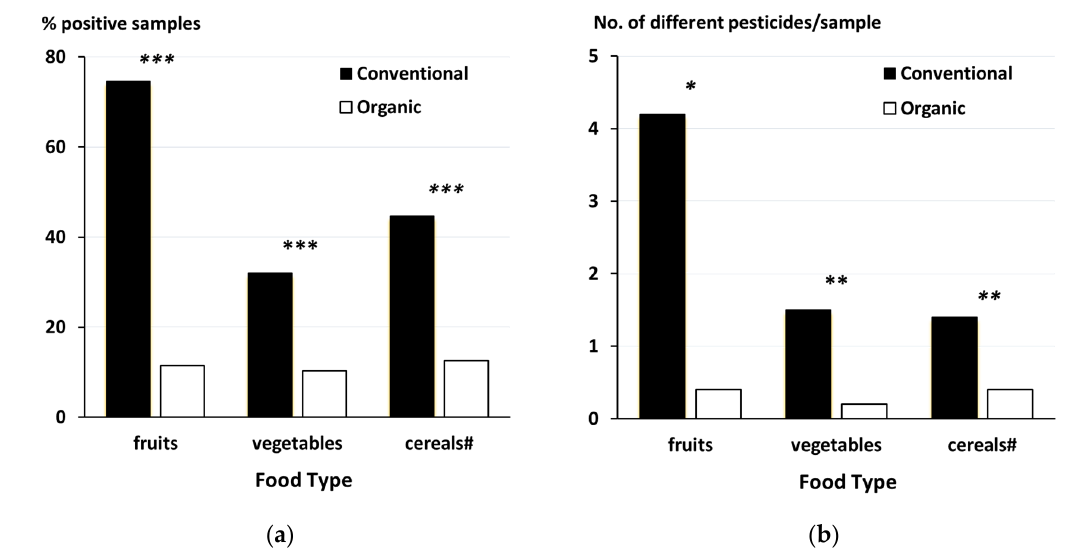
Figure 7. Effect of organic and conventional production methods on ( a ) the percent of samples testing positive for at least one pesticide residue. Data from [57], and ( b ) the number of different pesticide residues detected in fruits, vegetable and cereal-based foods. Data from [141]. #, cereals and cereal-based food products. ***, significant difference ( p < 0.001); **, significant difference ( p < 0.01); *, significant difference ( p < 0.05); T, trend (0.01 < p < 0.05); NS, not significant.